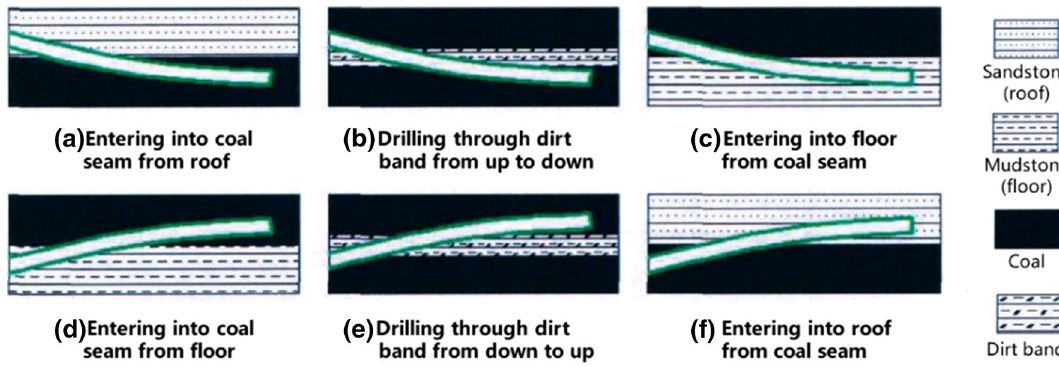
Fig. 21 Six typical coal seam crossing methods, modified from Zhao (2017)